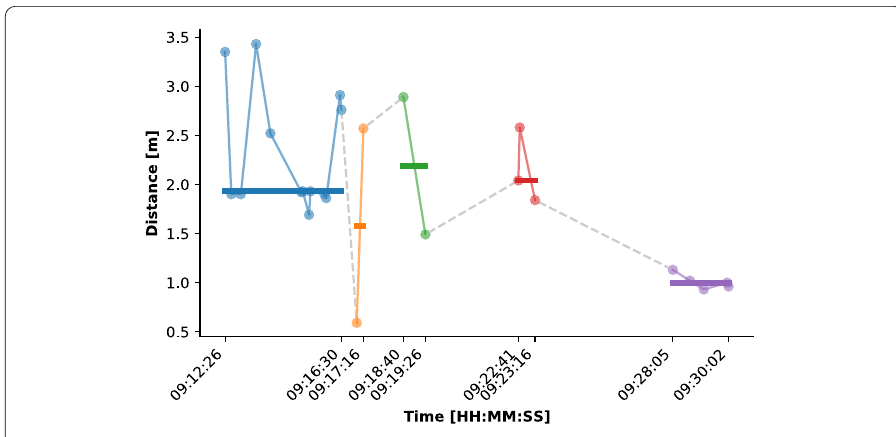
Figure 3 Measurement splitting and contact aggregation process. The figure shows the measurements collected in the first 20 min of August 8th, 2020, between node 26 and 27 at the AM - PRI camp. The measurements (light colors) are colored according to the division into contact characterized by τ time = 90 s and τ space = 2 m. Each contact is depicted as a horizontal bar from its beginning to its end, where the height of the bar represents the median